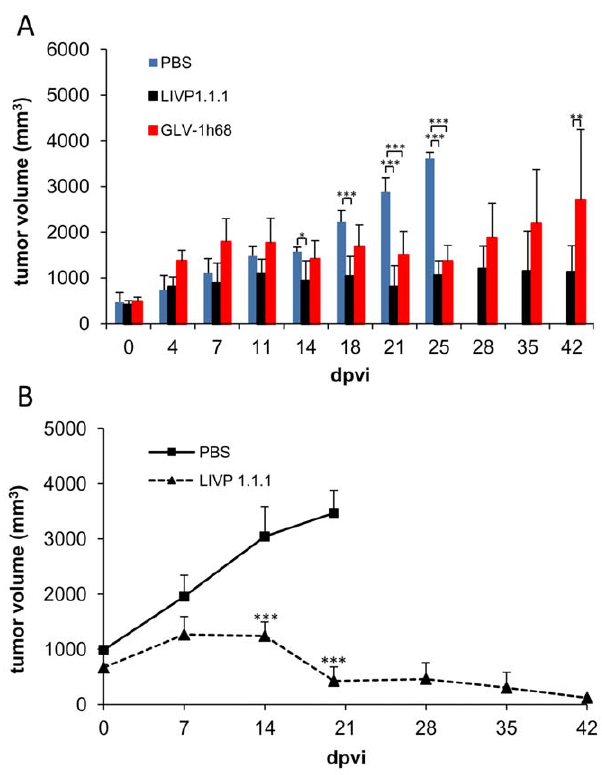
Figure 4. Growth of canine soft tissue sarcoma tumors in virus- and mock-treated mice. ( A ) Groups of STSA-1 tumor-bearing nude mice (n=6) were either treated with a single dose of 1 6 10 7 pfu GLV- 1h68, LIVP1.1.1 or with PBS (mock control). Tumor size was measured twice a week. Two-way analysis of variance (ANOVA) with Bonferroni post-test was used for comparison of two corresponding data points between groups. *, **, and *** indicate P , 0.05, 0.01, and 0.001, respectively. ( B ) Animals with established STSA-1 flank tumors ( . 600 mm 3 ) were distributed into two experimental groups (n=4 per group). Flank tumors were treated with injections of a single dose of LIVP1.1.1 (1 6 10 7 pfu) or PBS alone as control. The statistical significance was confirmed by Student’s t-test (***p , 0.001).